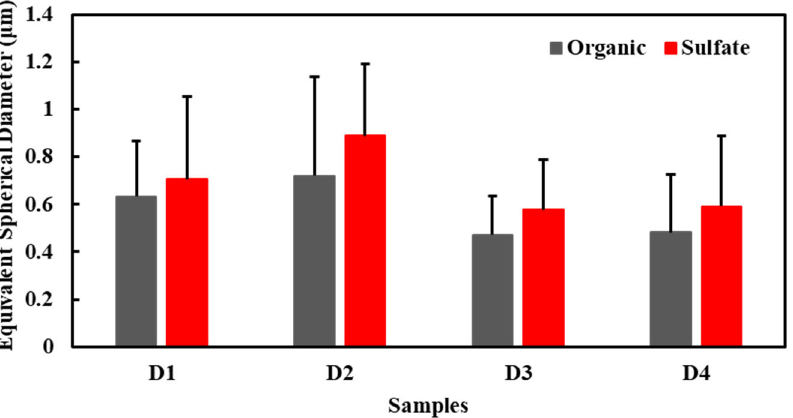
Figure 7. The average sizes of organic and sulfate particles in the daily samples of the winter haze in Xi’an during the sampling period.